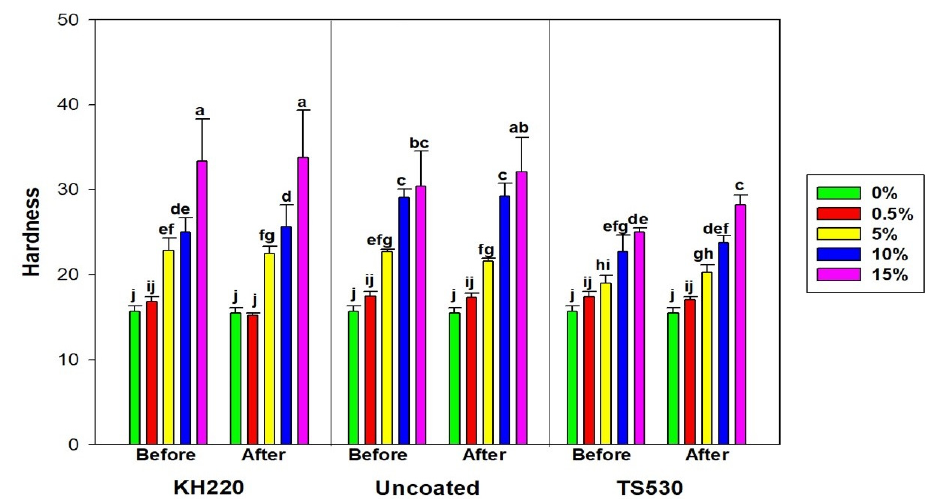
Figure 12. Bar graphs displaying means and error bars representing standard errors of means for Durometer Hardness for Indoor samples before and after 3000 h of storage. Lower case letters denote statistical groupings. Groups with means having the same lower-case letters are not significantly different ( p > 0.05, ANOVA/Tukey). Comparisons are both within and across materials.